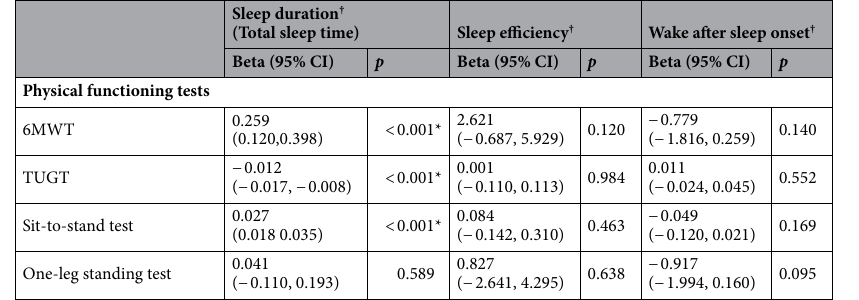
Table 5. Multivariable regression model for objective sleep measures with physical performance. * p < 0.05. † Adjusted for age, gender, BMI, education level, time since diagnosis, current treatment, marital status, KPS score, step count, smoking, drinking behaviour, fatigue, anxiety, depression and Charlson Comorbidity Index.